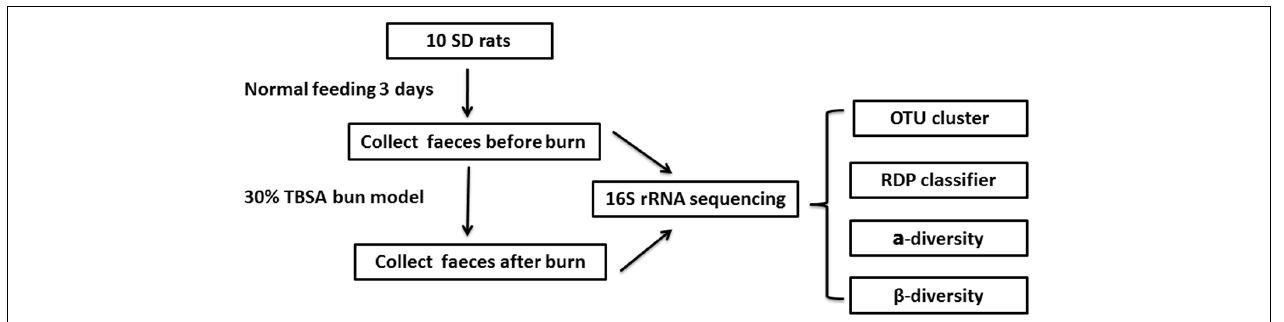
FIGURE 1 | Diagrammatic sketch of the experimental